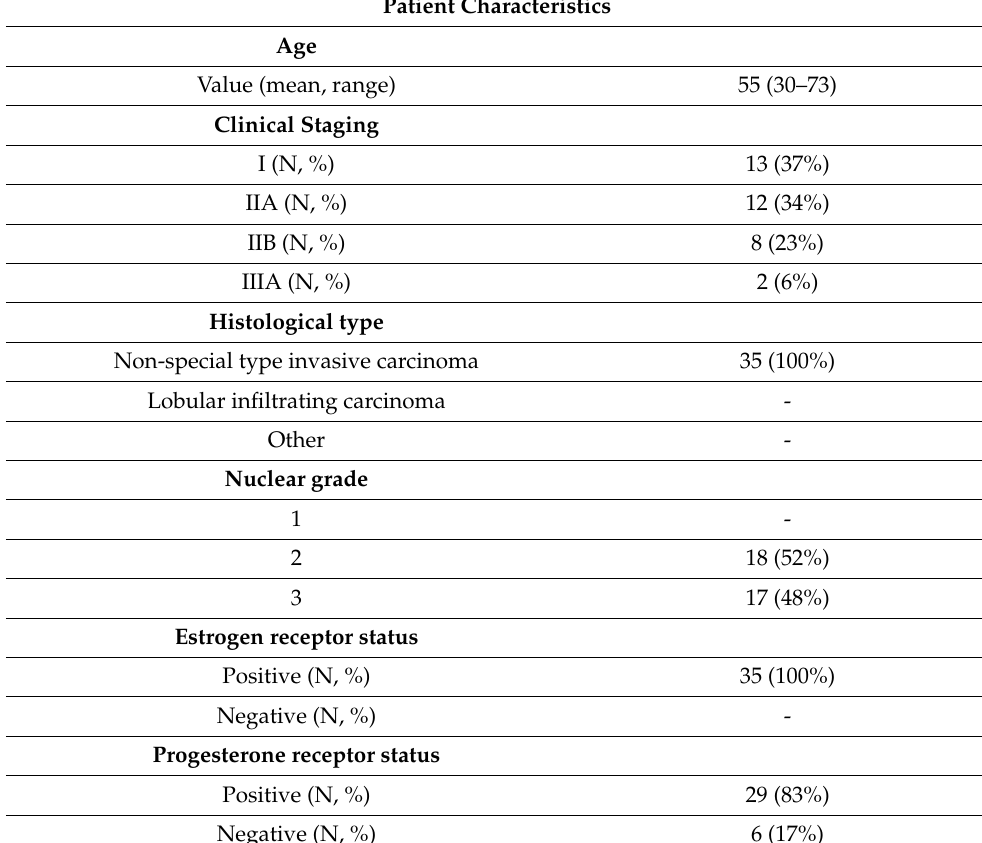
Table 2. Patient